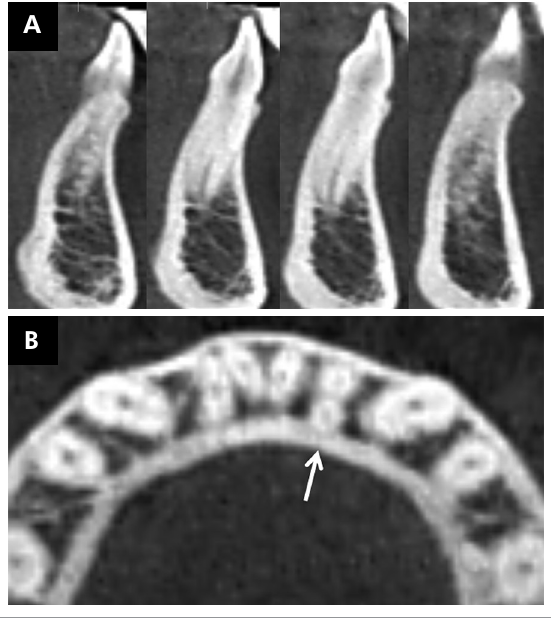
Figure 1. Sagittal (A; 1 mm sequential sections) and axial sections (B) showing a lateral incisor with two roots (arrow).